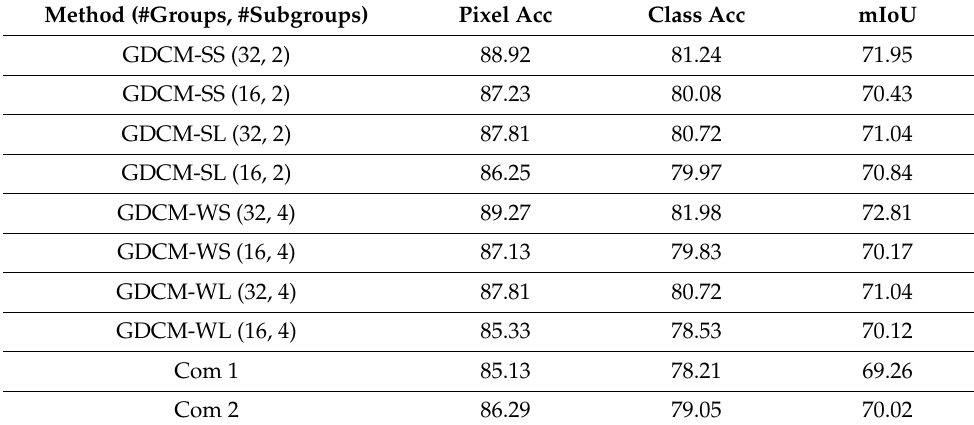
Table 7. Comparison of accuracy per method (unit: %).